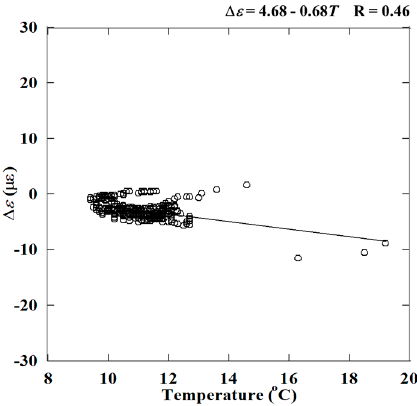
Figure 11. Signal pattern before corrosion is applied.